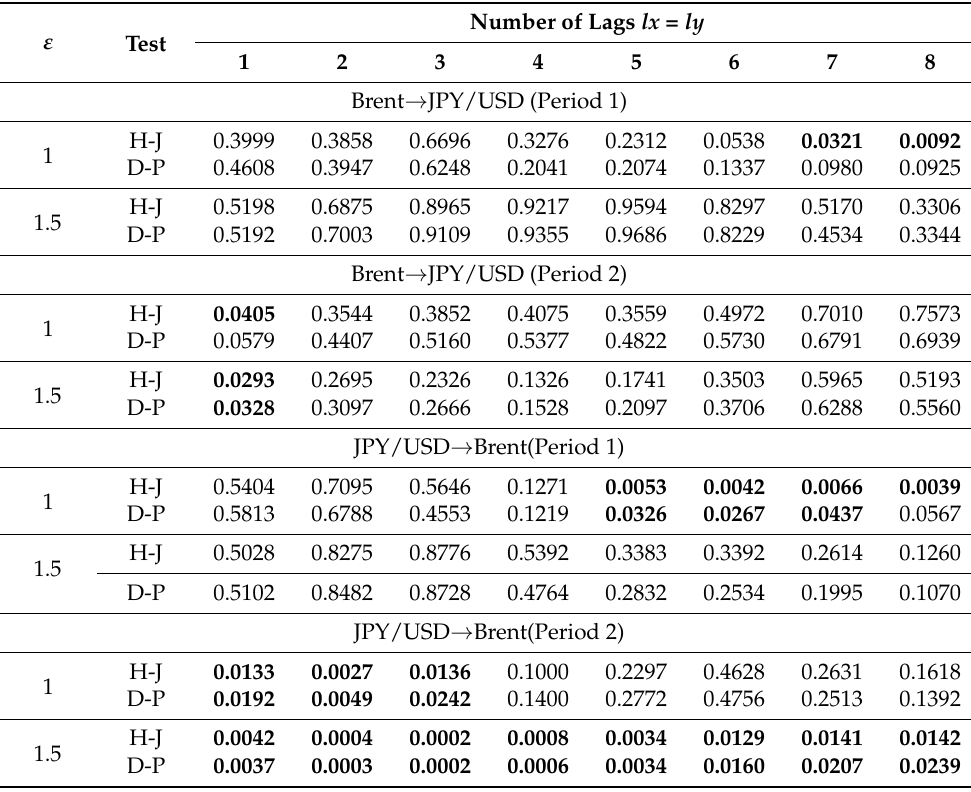
Table 4. Results of nonlinear Granger causality testing for crude oil and